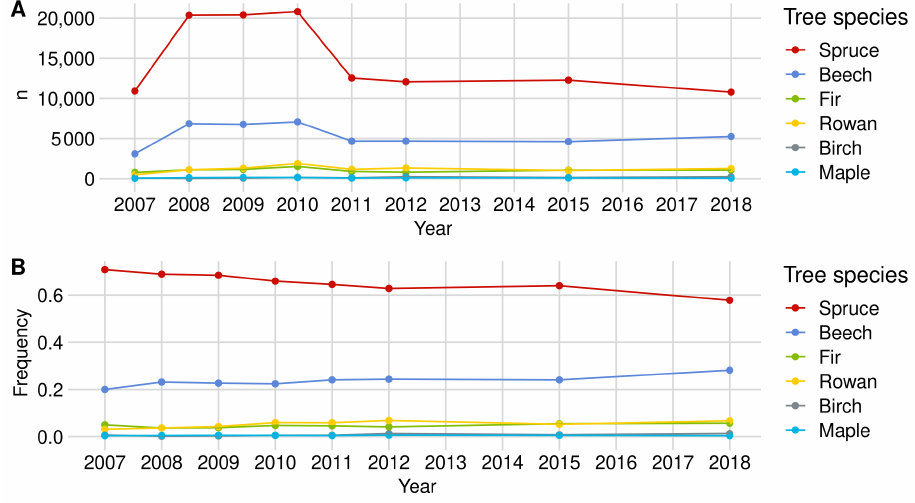
Figure A1. Sample size development of the main tree species over time in the NP in ( A ) total numbers (n) and ( B ) relative frequency.